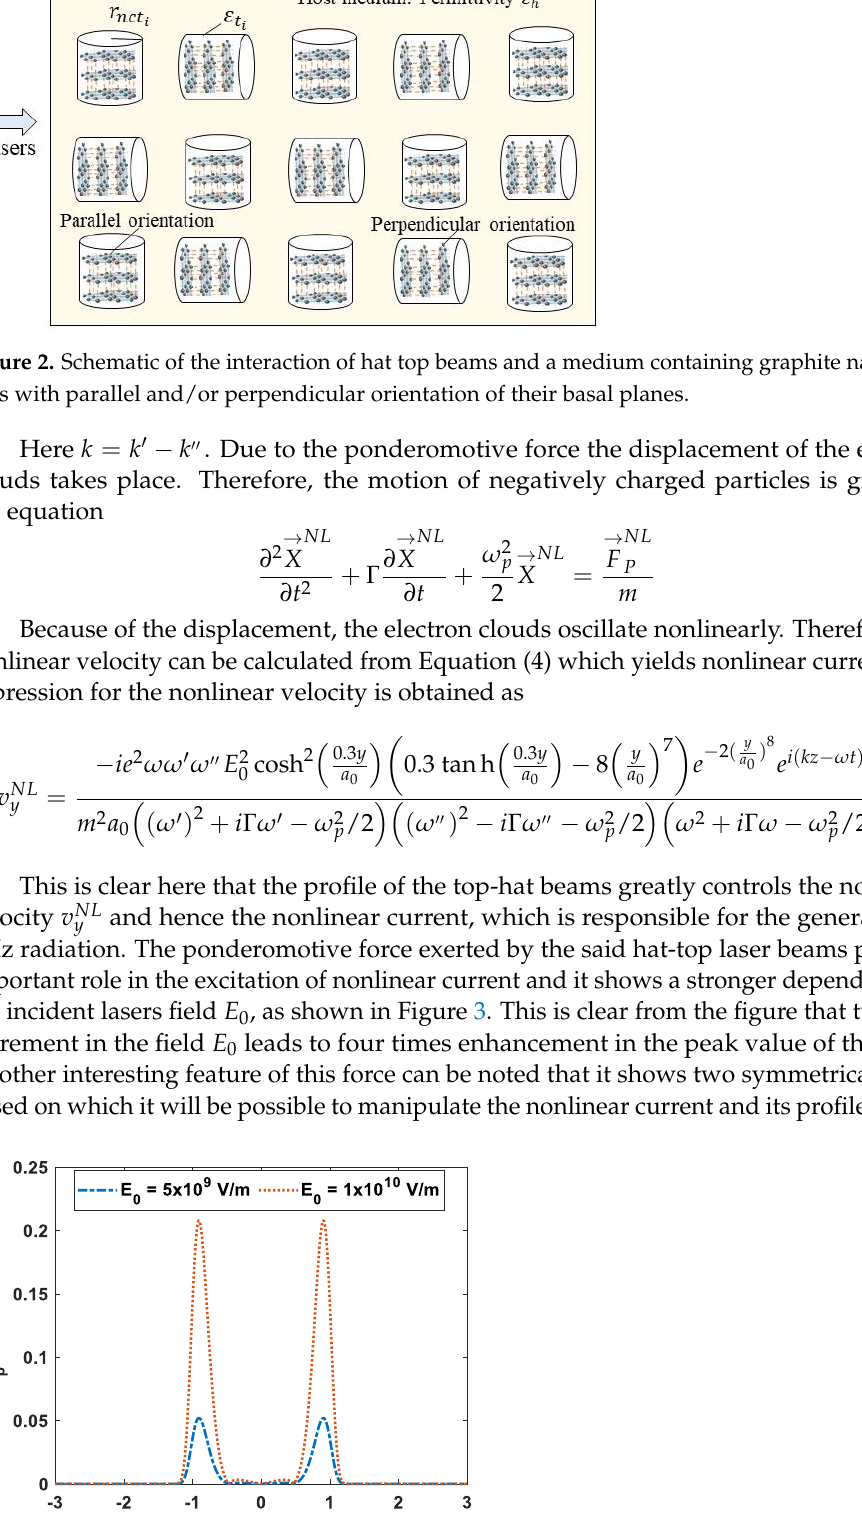
Figure 3. Variation of ponderomotive force with transverse distance from the beam axis for different values of incident lasers electric field, when 𝜔 ′ = 1.884 × 10 14 rad/s, 𝜔 ′′ = 1.811 × 10 14 rad/s, ℎ 𝑛𝑐 = 5𝑟 𝑛𝑐 and 𝑑 𝑛𝑐 = 6𝑟 𝑛𝑐 of the nanocylinders.